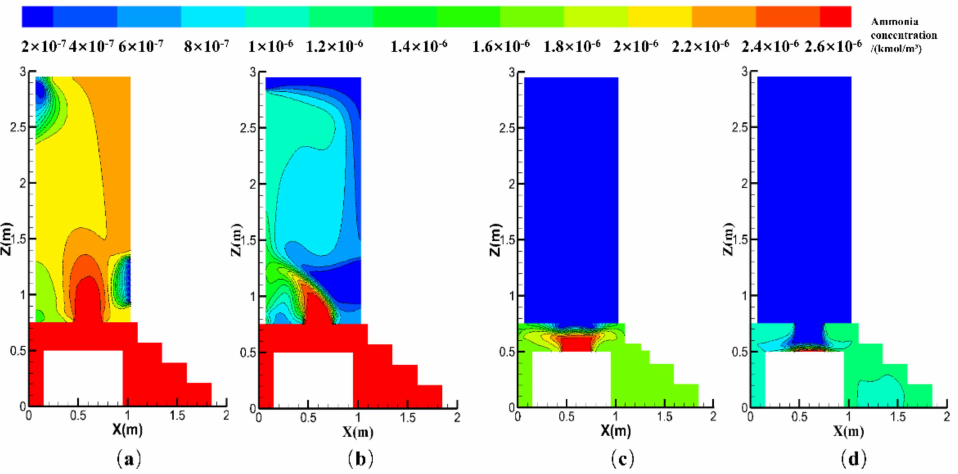
Figure 5. Ammonia concentration distributions with different ACH (unit: h − 1 ) values for Cases 1 and 2. Case 1: ( a ) ACH = 5, ( b ) ACH = 10; Case 2: ( c ) ACH = 5, ( d ) ACH = 10.